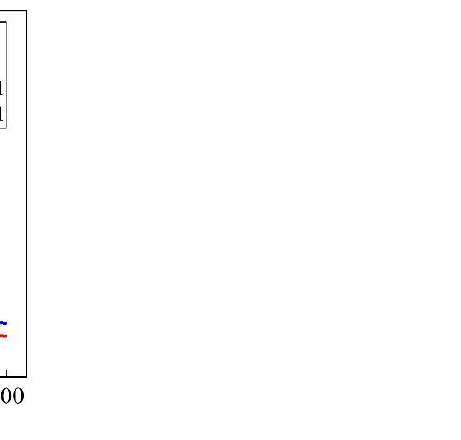
Figure 6. Comparison of the experimental and numerical results on the concentration of the leaked hydrogen.